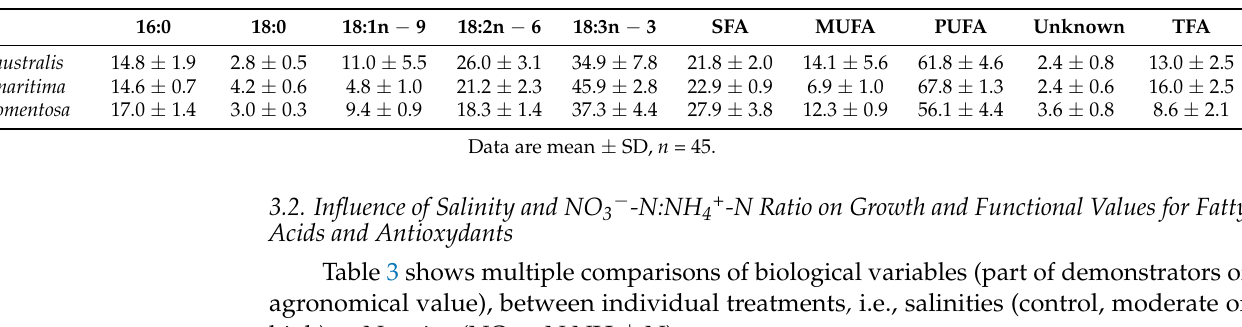
Table 2. Mean total fatty acid (TFA) content (mg g DW − 1 ) and proportions (%TFA) of major fatty acids (palmitic acid 16:0, stearic acid 18:0, oleic acid 18:1n − 9, linoleic acid 18:2n − 6 and α -linolenic acid 18:3n − 3) and of fatty acids classes (saturated SFA, monounsaturated MUFA, polyunsaturated PUFA and unknown) in leaves of the three species, on all treatments.